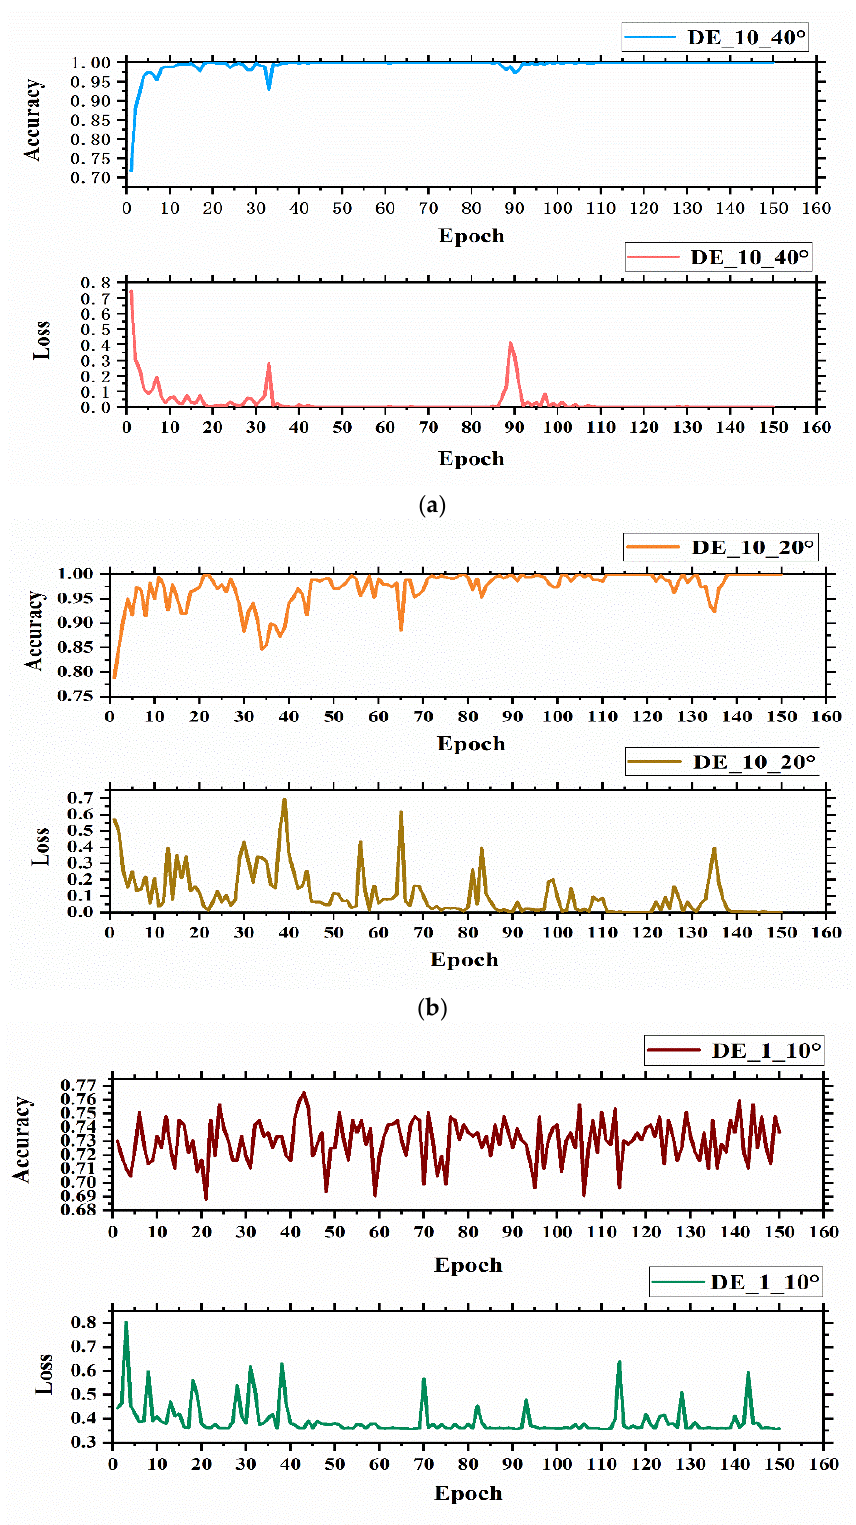
Figure 4. Accuracy of VGG16 experimental results with different parameters at θ = 120 ◦ . ( a ) l = 10, ζ = 40 ◦ . ( b ) l = 10, ζ = 20 ◦ . ( c ) l = 1, ζ = 10 ◦